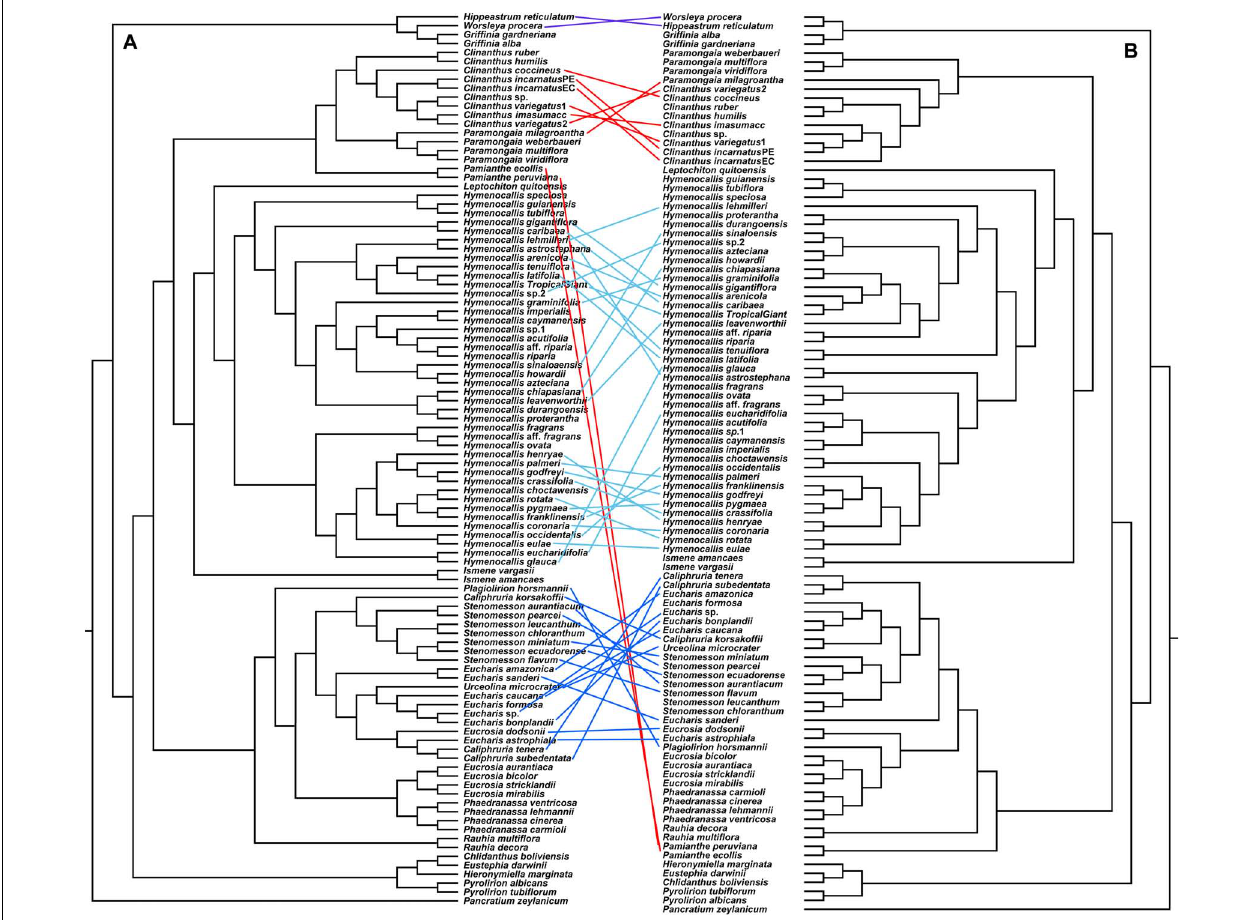
FIGURE 5 | “Tanglegram” created from the best ML 70% taxon coverage nuclear supermatrix ( Supplementary Figure 3 ) and the plastome trees ( Figure 4 ) graphically showing cytonuclear discordance between the two partitions. A = nuclear tree, B = plastome tree.